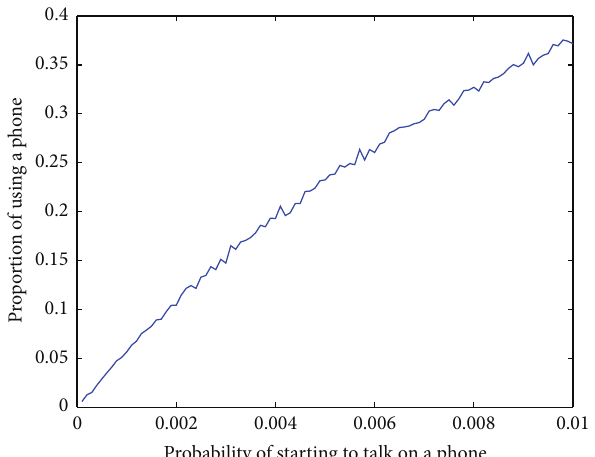
Figure 1: The relationship between 𝑝